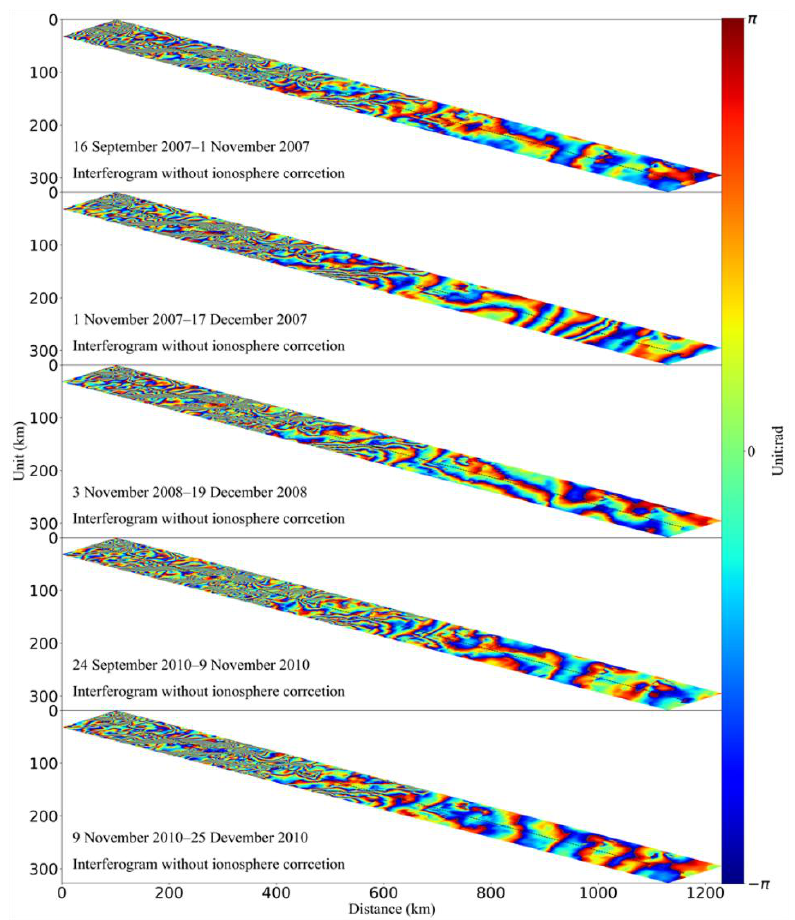
Figure 7. Time-series SAR Interferograms without ionospheric correction in Antarctica. The five original interferograms correspond to the five acquisition times in Table 1.